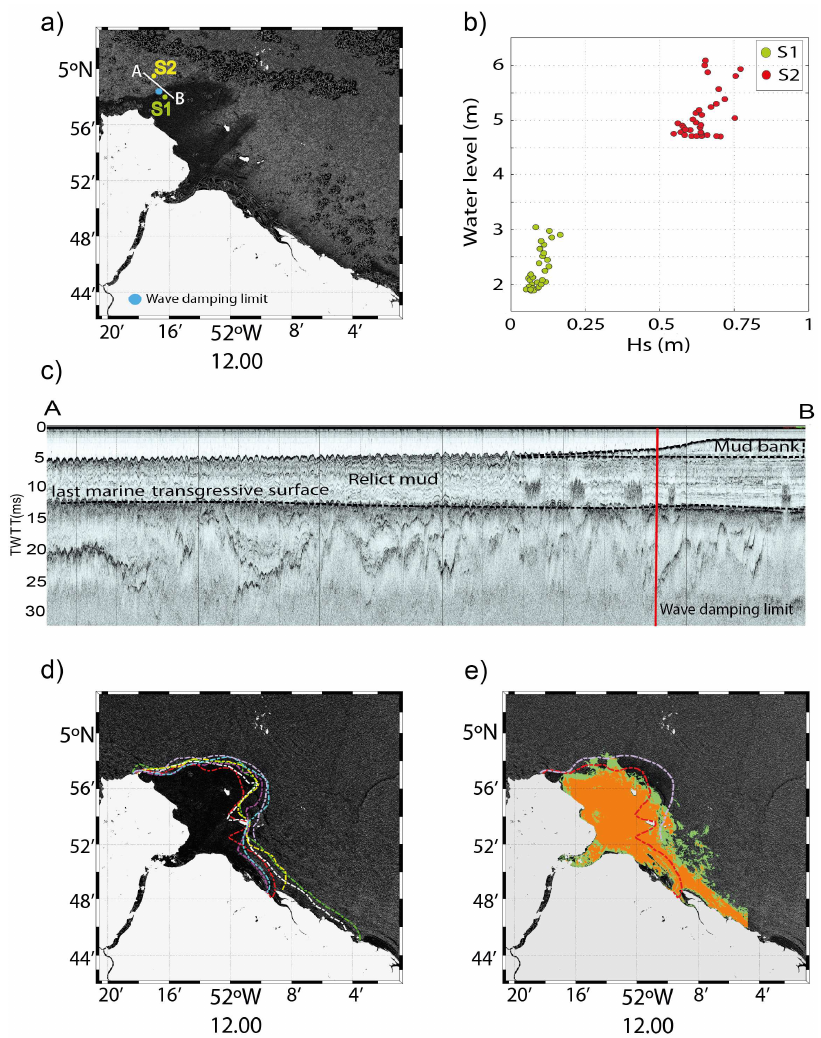
Figure 3. Wave damping over the mud bank located in front of Cayenne Island. ( a ) Wave damping over the bank for November 2017. ( b ) Wave height (Hs) in the mud bank area (S1 in Figure 3a) and in the interbank area (S2 in Figure 3a). ( c ) Identification of the wave-damping limit over the seismic profile (A to B in Figure 3a) for November 2017. ( d ) Wave detection method using the panchromatic band of Landsat 8 for the maps corresponding to the dry season of 2015. The different coloured lines correspond to the wave damping limits detected for each OLI map of the dry season of 2015. ( e ) Comparison of mud bank position detection using SPM values and bank position estimated using the extreme values (for the first and the last OLI map of the season) of wave damping for the dry season of 2015.